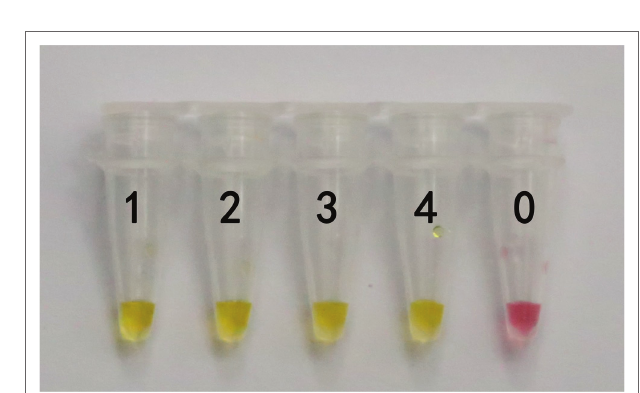
FIGURE 6 | Applicability results of LAMP assay with boiled mushrooms. Applicability analysis of the LAMP method established in this study was evaluated by using boiled mushrooms to simulate the processing of mushrooms. 1. Gyromitra infula. 2. 50% Gyromitra infula + 50% Morchella